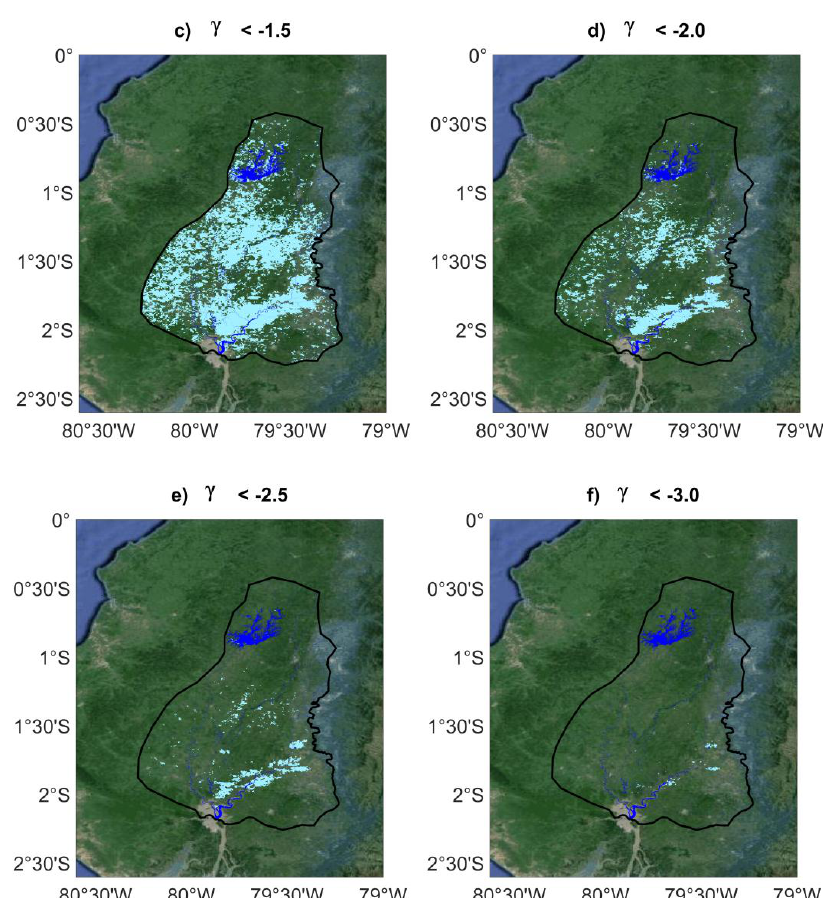
Figure 7. Inundation in the Guayas watershed using the SWR from DFO ( a ). Normalized anomalies of backscattering coefficients ( γ ) lower than a given threshold appear in light blue. The threshold values equal − 1.0 ( b ); − 1.5 ( c ); − 2.0 ( d ); − 2.5 ( e ); and − 3.0 ( f ) for 2008. Background image is from Google Maps. Permanent water bodies appear in blue.